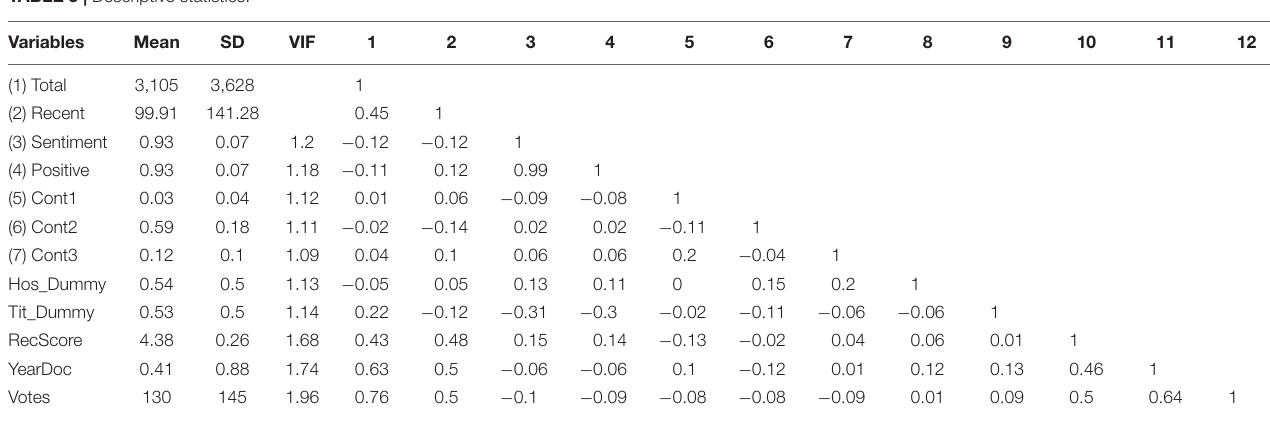
TABLE 5 | Descriptive